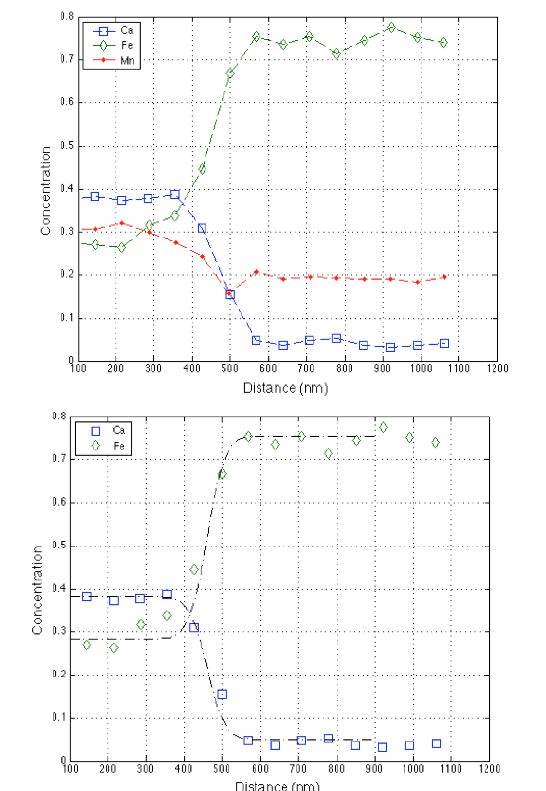
Figure 4. Measured concentration profiles (Top, Figure 4a) and modeled concentration profiles with Dt=7.5x10 12 cm 2 (bottom, Figure 4b). [ 14 ]